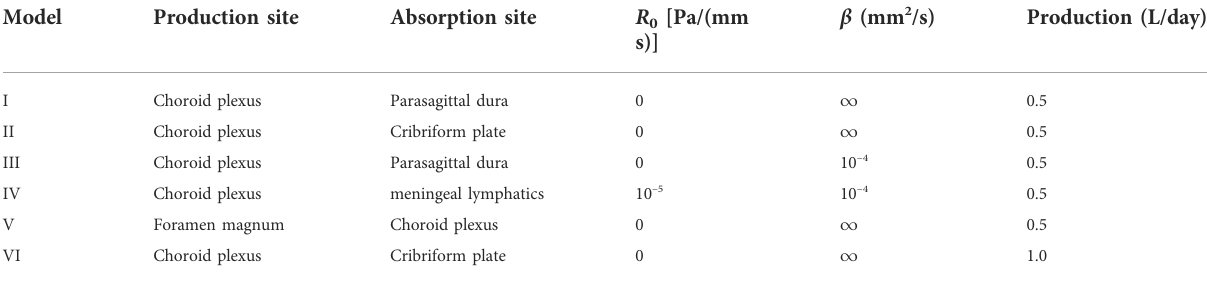
TABLE 2 Overview of computational models. Production and absorption sites refer to the production sites for CSF and ef fl ux/absorption sites of CSF and the solute concentration, respectively. R 0 is a CSF ef fl ux resistance parameter cf. (2), while β represents a diffusive resistance to molecular ef fl ux cf. (6). The values for R 0 and β were estimated by numerical experimentation.